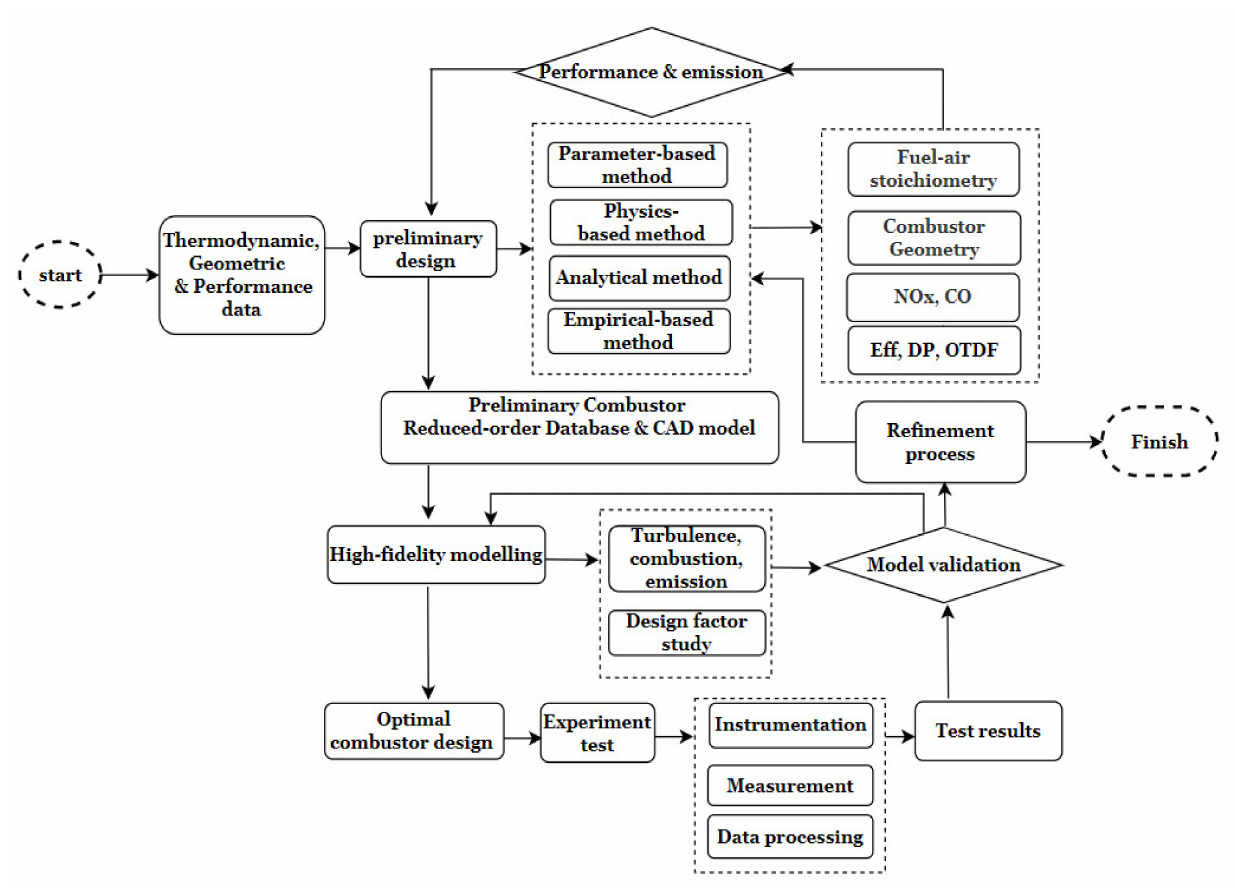
Figure 1. Overview of the design and modelling